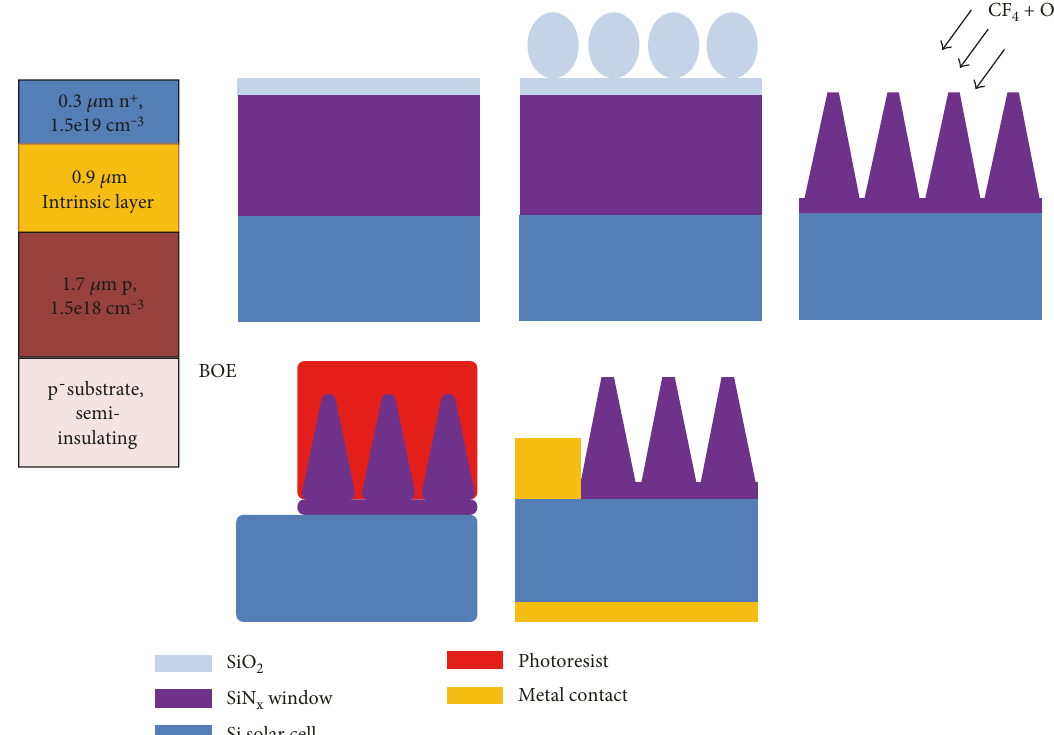
Figure 6: Schematics of the fabrication process of ultrathin c-Si solar cells with NDL on top. (a) Deposit a c-Si solar cell with ultrathin absorber on a semi-insulating substrate using RPCVD; (b) deposit the SiN monolayer of silica nanospheres on top; (d) dry etch the SiN BOE to de fi ne the top contact region; and (f) create front and back metal